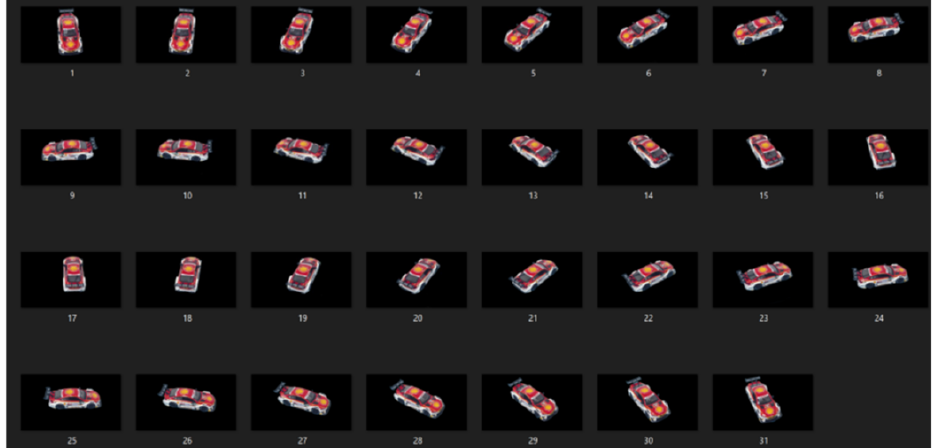
Figure 22. The dataset after